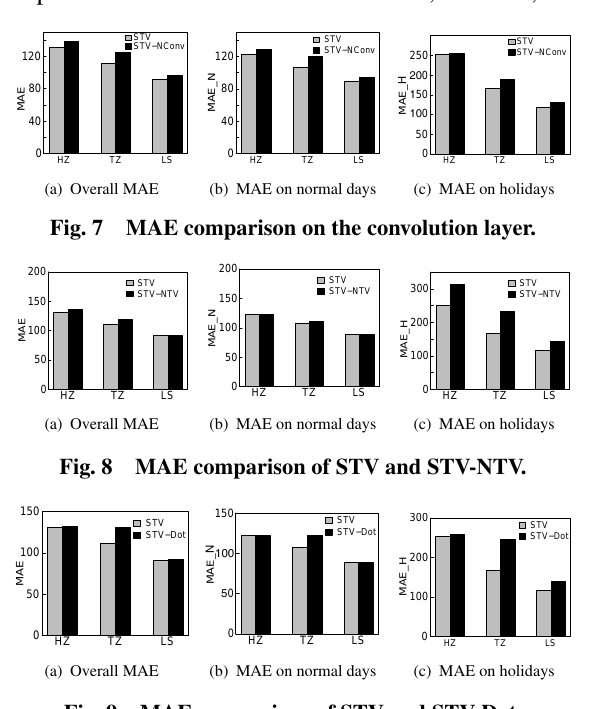
Fig. 11 Training efficiency of different